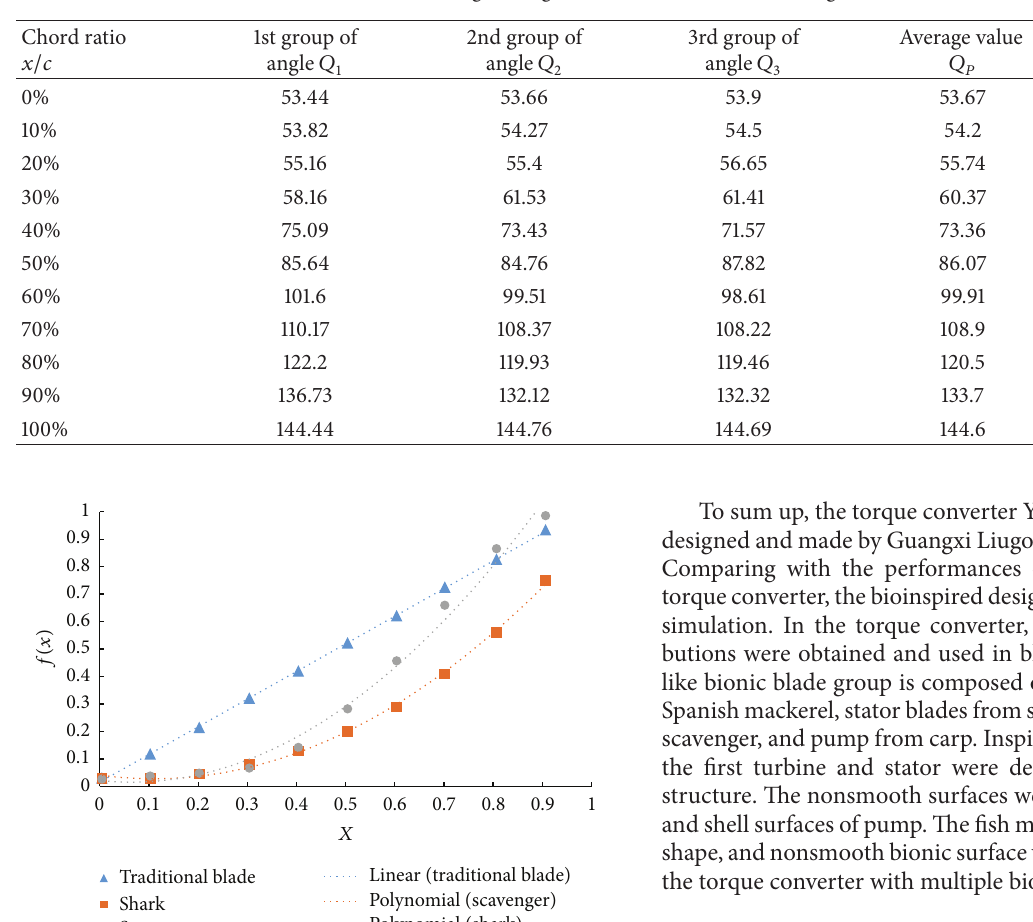
Table 1: Angle along the chord and its location of tiger shark.